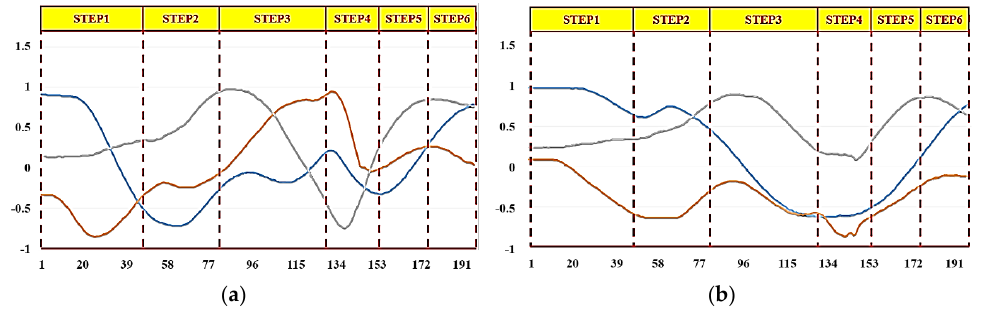
Figure 12. Complete action signal of the right hand : x-axis acceleration signals (blue line); y-axis acceleration signals (orange line); z-axis acceleration signals (gray line). ( a ) forearm, ( b ) upper arm.